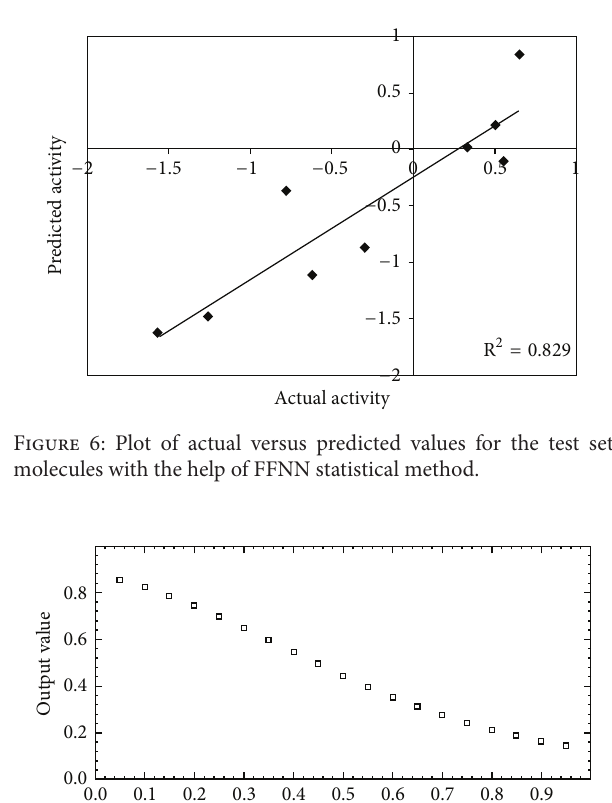
Figure 7: Dependency graph illustrating the correlation between the molecular mass (substituent 3) used to train the neural network architecture versus the actual activity data.